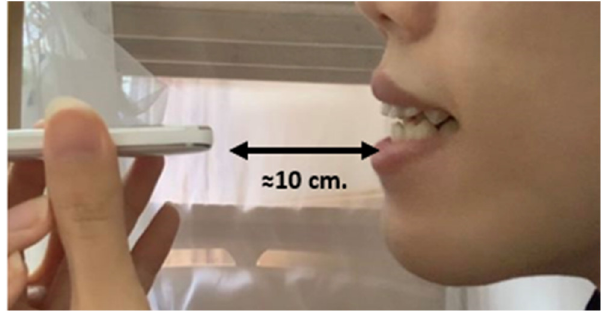
Figure 3. Setup of speaking position.